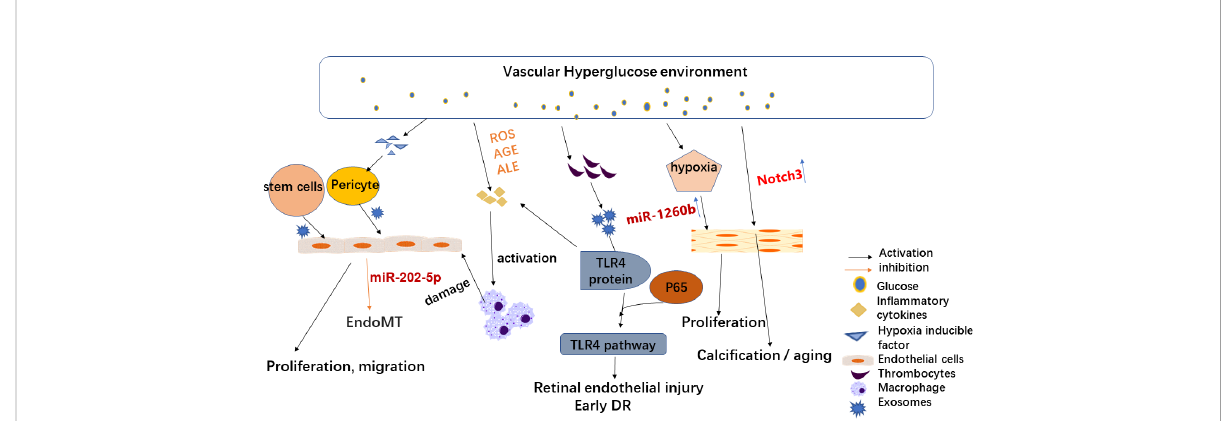
FIGURE 1 Effects of exosomes on diabetic retinopathy-related cells. High-glucose environment and hypoxia alter circulating exosomes and play a key role in DR development. Therefore, stem cell exosomes may be an effective treatment for DR. Hypoxia-induced increased secretion of hypoxia- inducible factors can lead to endothelial dysfunction (ED) and promote endothelial cell permeability in vitro . Hypoxia also leads to changes in circulating exosomes (such as miR-1260b), resulting in the proliferation of vascular smooth muscle cells. A high-glucose microenvironment also leads to a greater generation of reactive oxygen species (ROS) and the build-up of advanced glycation or lipid oxidation end products (AGE or ALE), which in turn leads to in fl ammatory increased cytokines (TNF- a , the secretion of IL-6) and thus to in fl ammation and exacerbates the harm of DR. PRP-Exos participate in early DR formation via mediating hyperglycemia-induced retinal endothelial damage by upregulating the TLR4 signaling